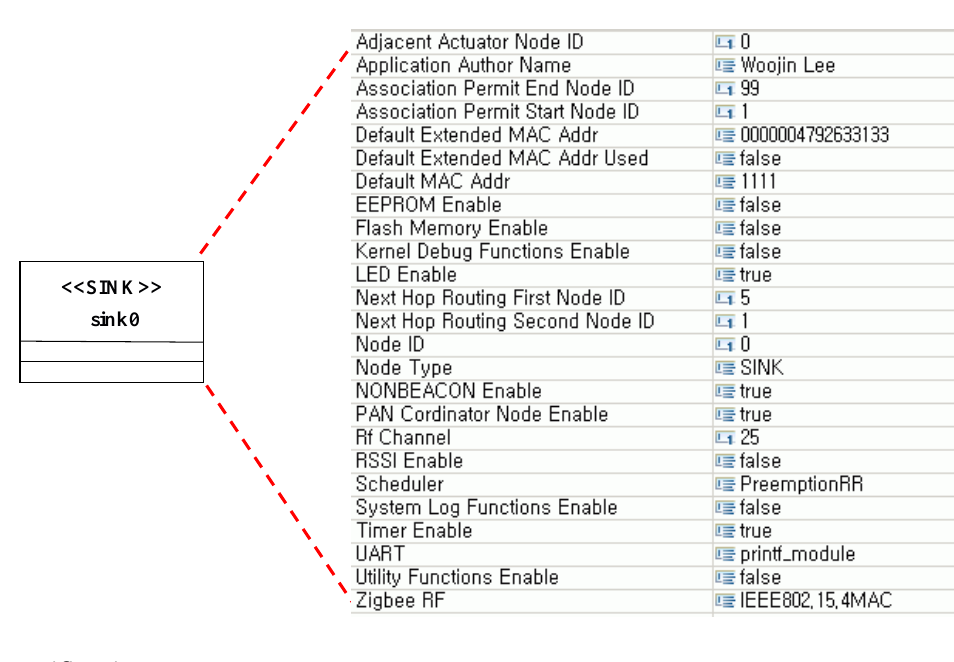
Figure 3. Attributes values setting for